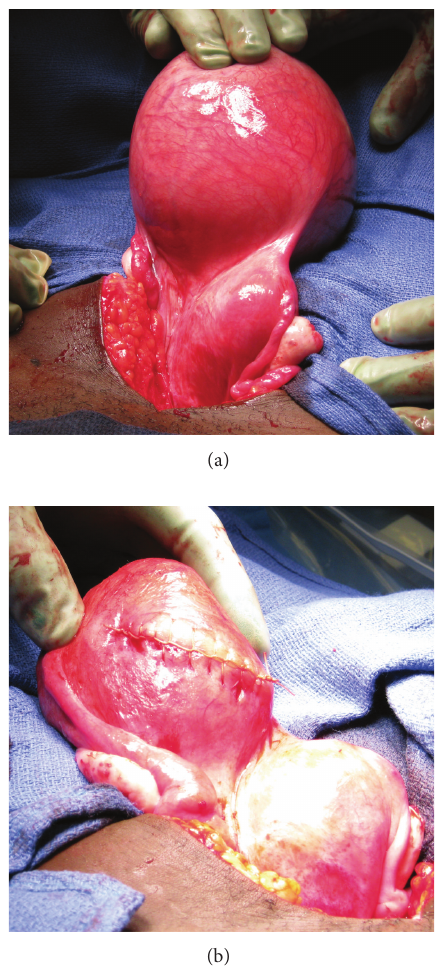
Figure 2: The gross appearance of the bicornuate uterus during surgery:(a)beforeuterineevacuation,withfetus insitu ,and(b)after removal of the fetal remains and hysterotomy closure.